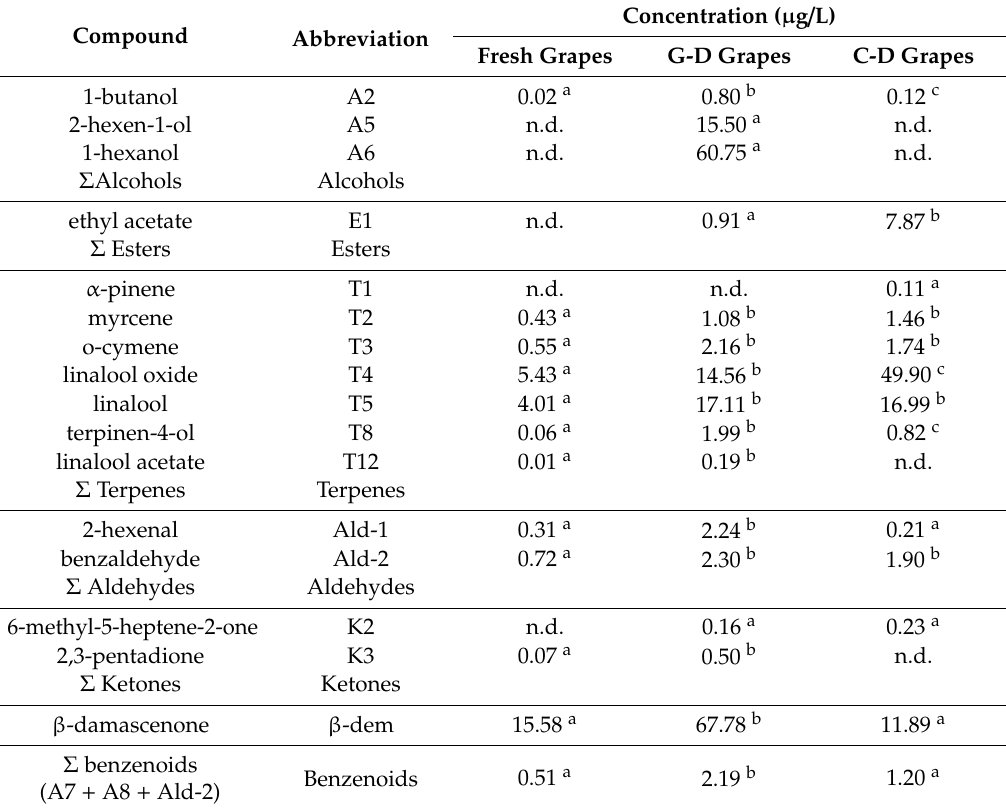
Table 3. Bound fraction of volatile aroma compounds in fresh grapes, greenhouse-dried (G-D) grapes, and chamber-dried (C-D) grapes at 50 ◦ C as average values of three